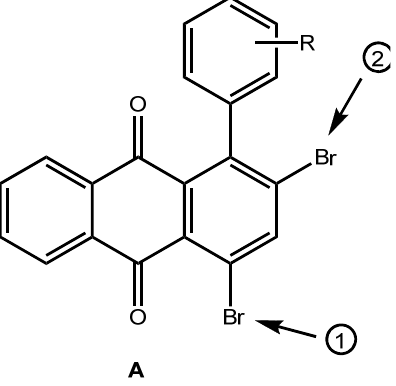
Figure 3. Order of entry of further aryl substituents by Suzuki-Miyaura cross-coupling